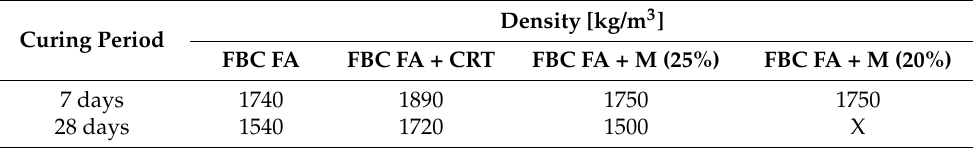
Table 5. Density of samples made of different mixtures, measured after 7 and 28 days of curing.